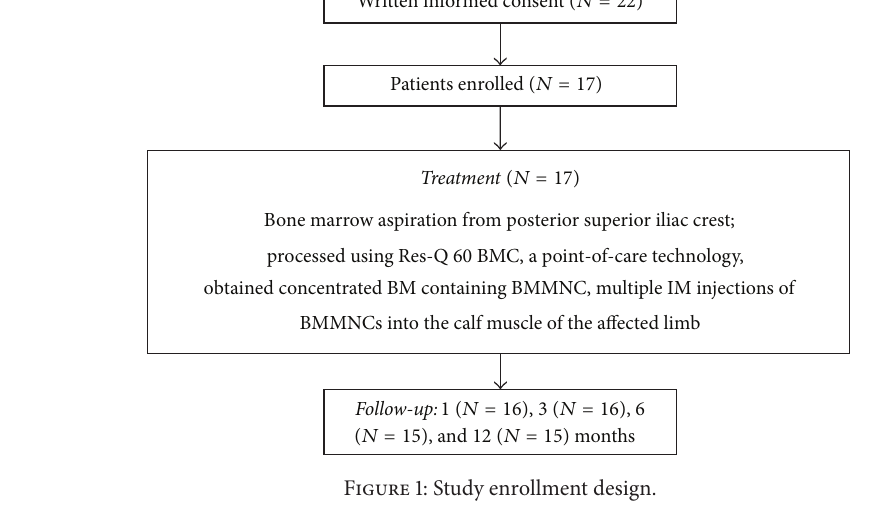
Figure 1: Study enrollment design.